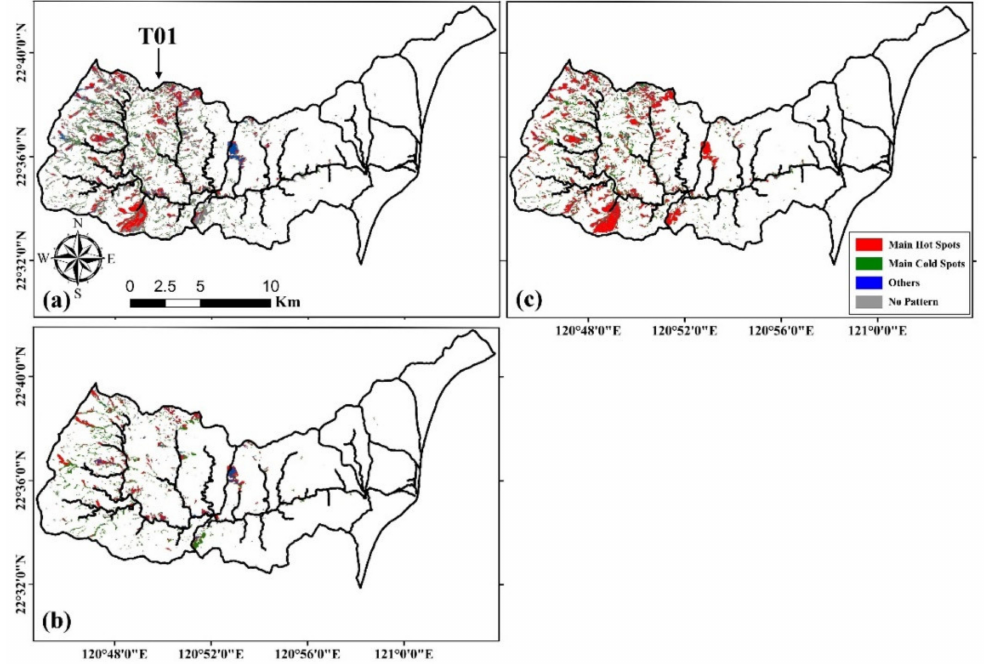
Figure 12. The main landslide hot spot and cold spot from 2005 to 2015 ( a ), from 2005 to 2008 ( b ), and from 2010 to 2015 ( c ) in the TRW